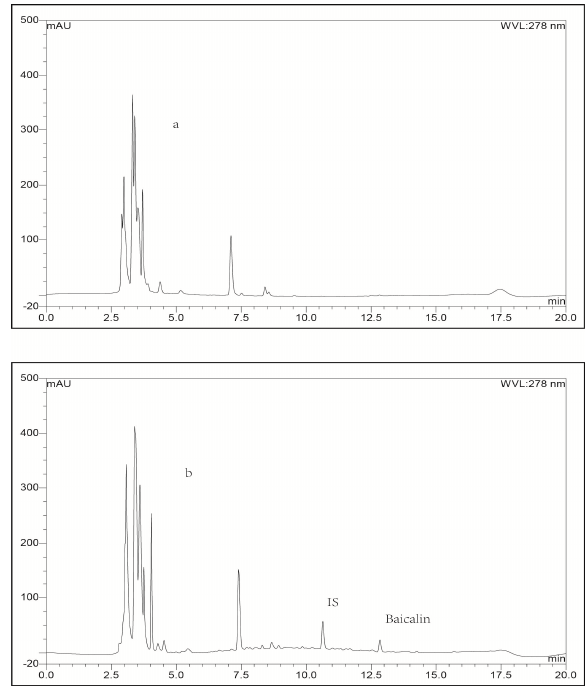
Figure 8. Representative LC-UV chromatograms obtained for blank stomach tissue ( a ) and stomach bio-sample collected from a rabbit at 0.25 h after intravenous administration of baicalin-loaded liposomes at a dose of 10 mg/kg + IS ( b ).